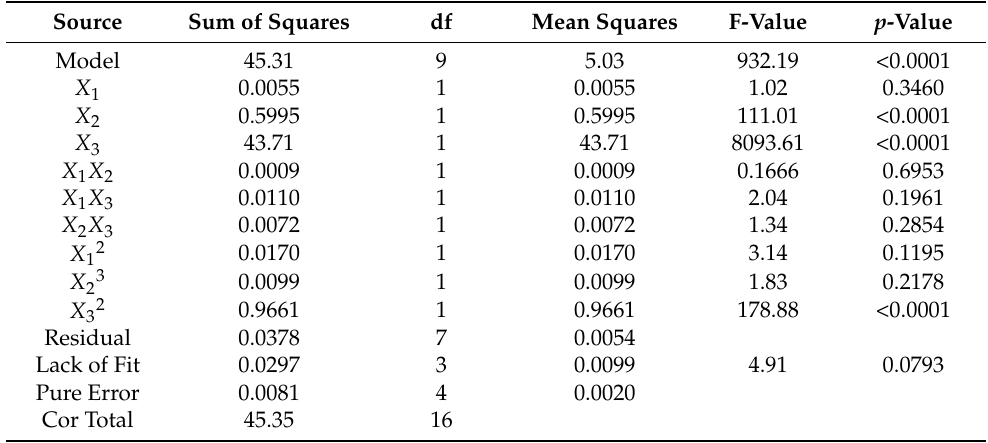
Table 4. Analysis of Variance (ANOVA) of the regression equation of CA against the growth of E. sakazakii